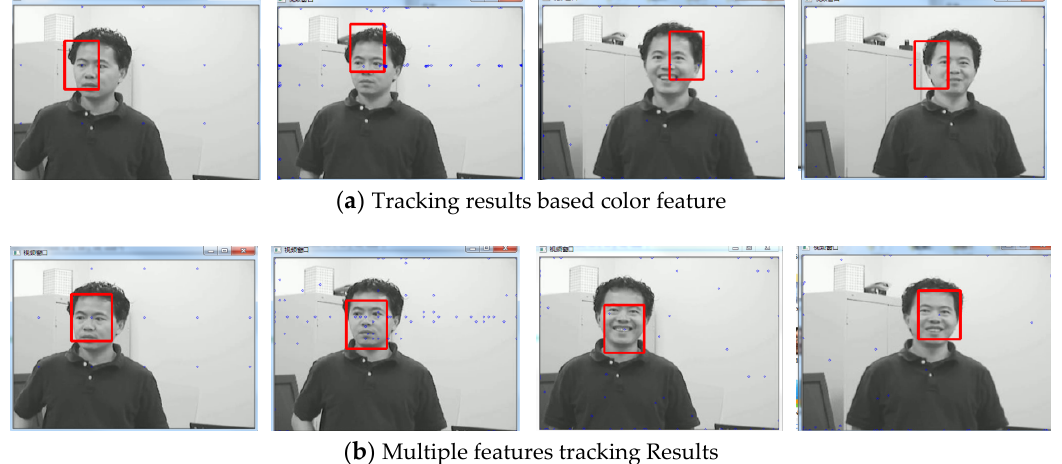
Figure 16. Tracking results under the background changes.